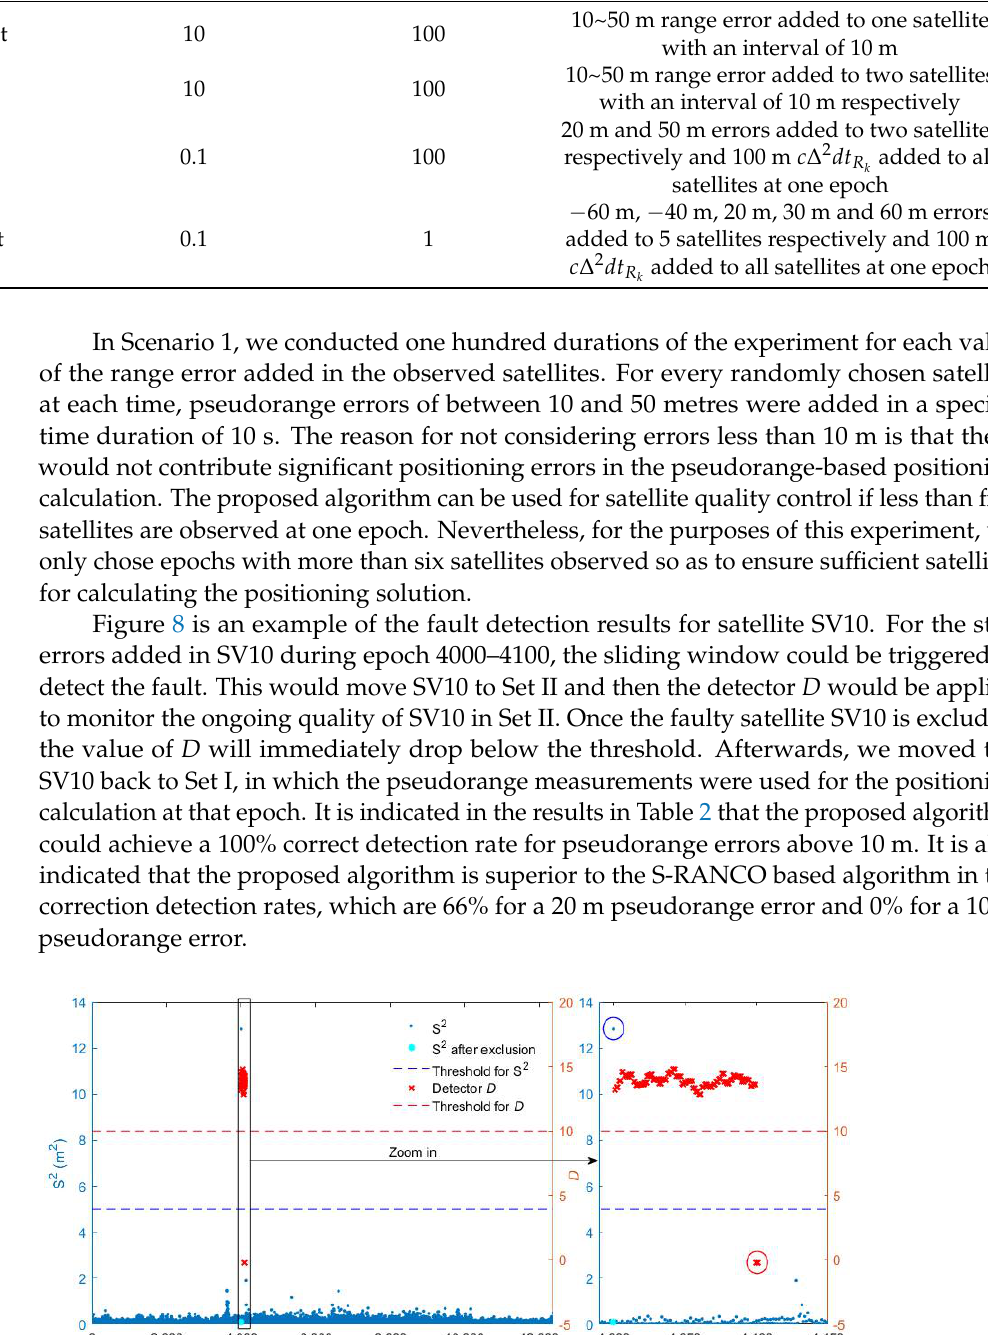
Table 1. The defined scenarios.